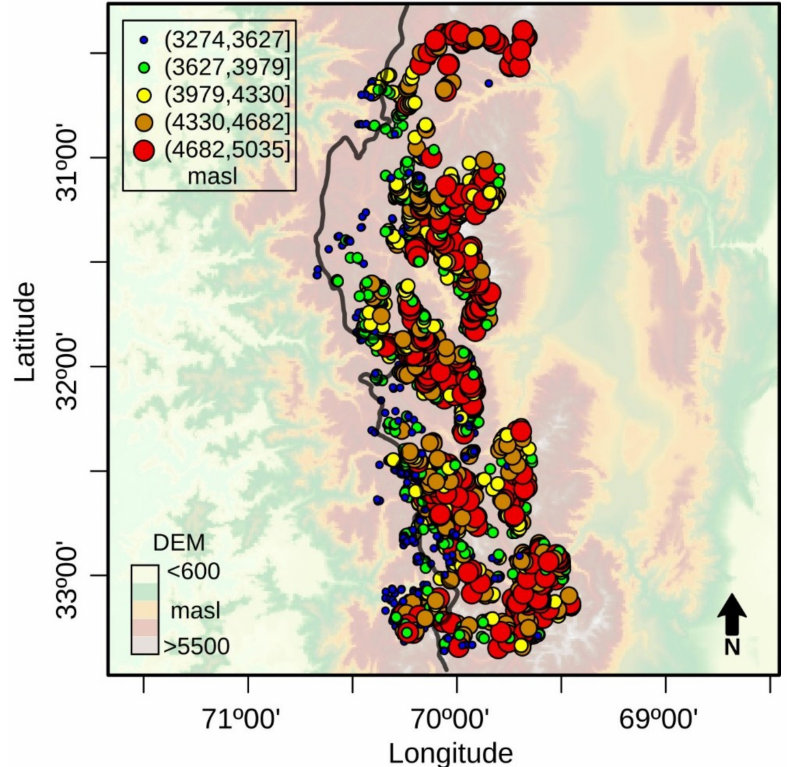
Figure 3. Map of spatio-altitude distribution of active rock glaciers. The black line indicates the national